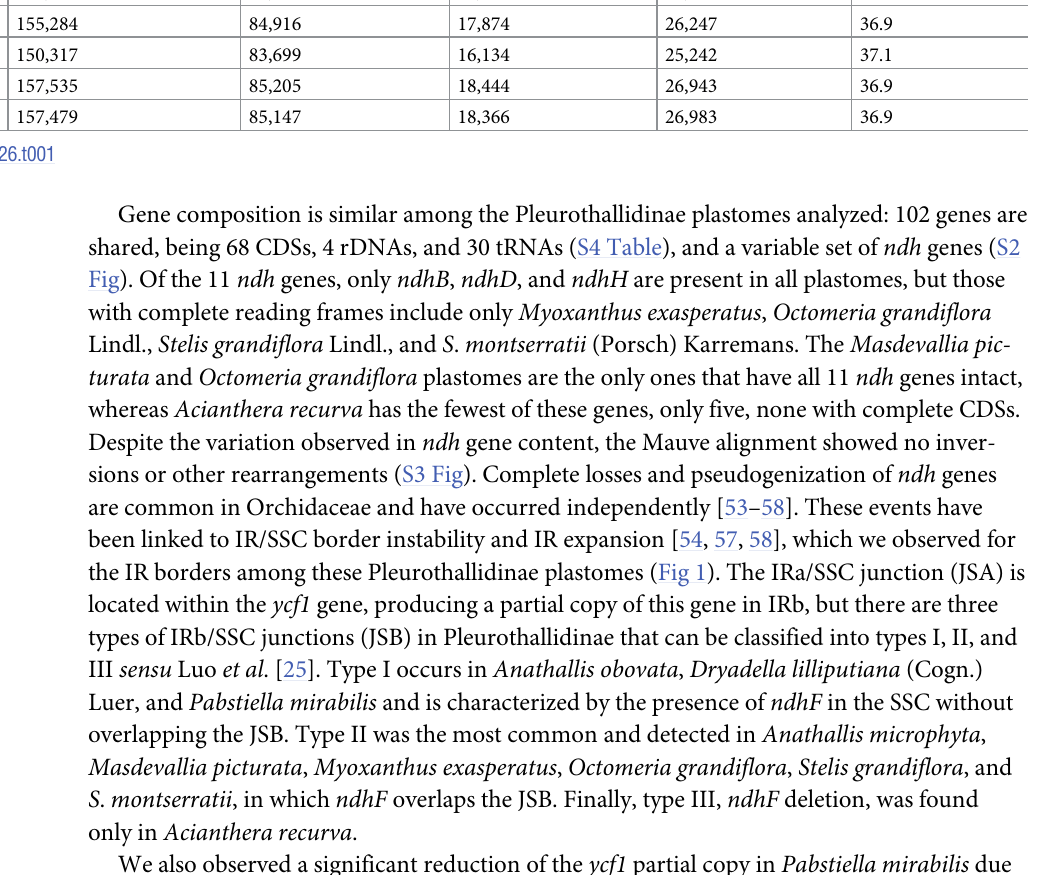
Fig). Of the 11 ndh genes, only ndhB , ndhD , and ndhH are present in all plastomes, but those with complete reading frames include only Myoxanthus exasperatus , Octomeria grandiflora